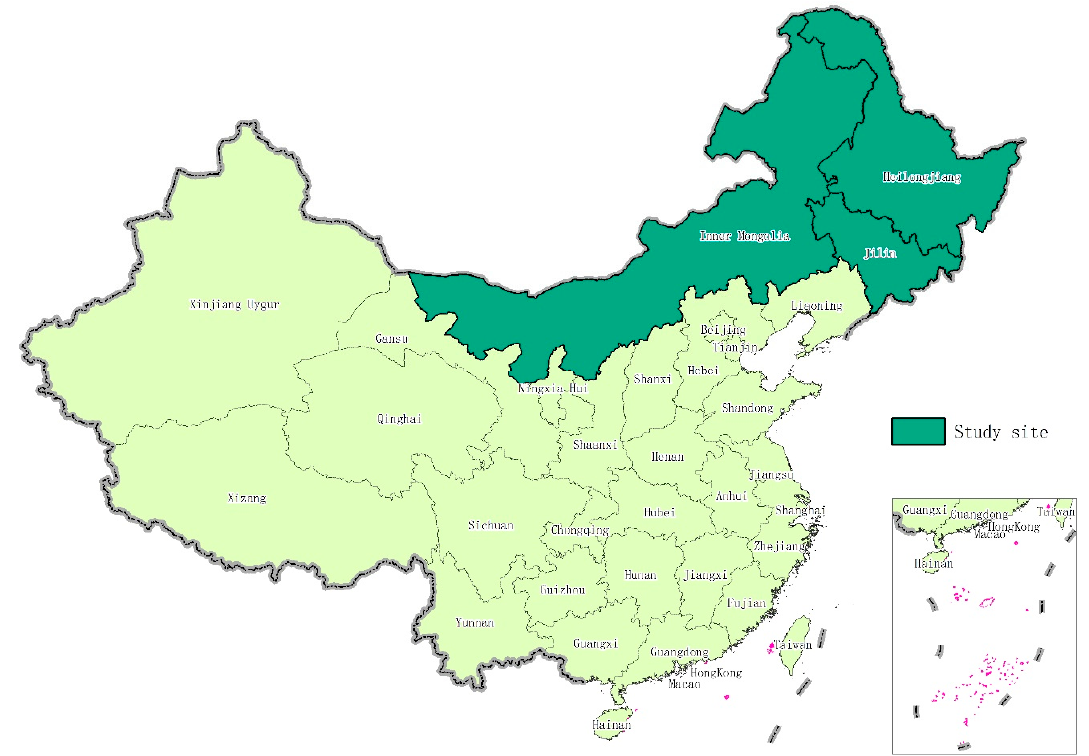
Figure 1. Distribution of study site in Northeast China.